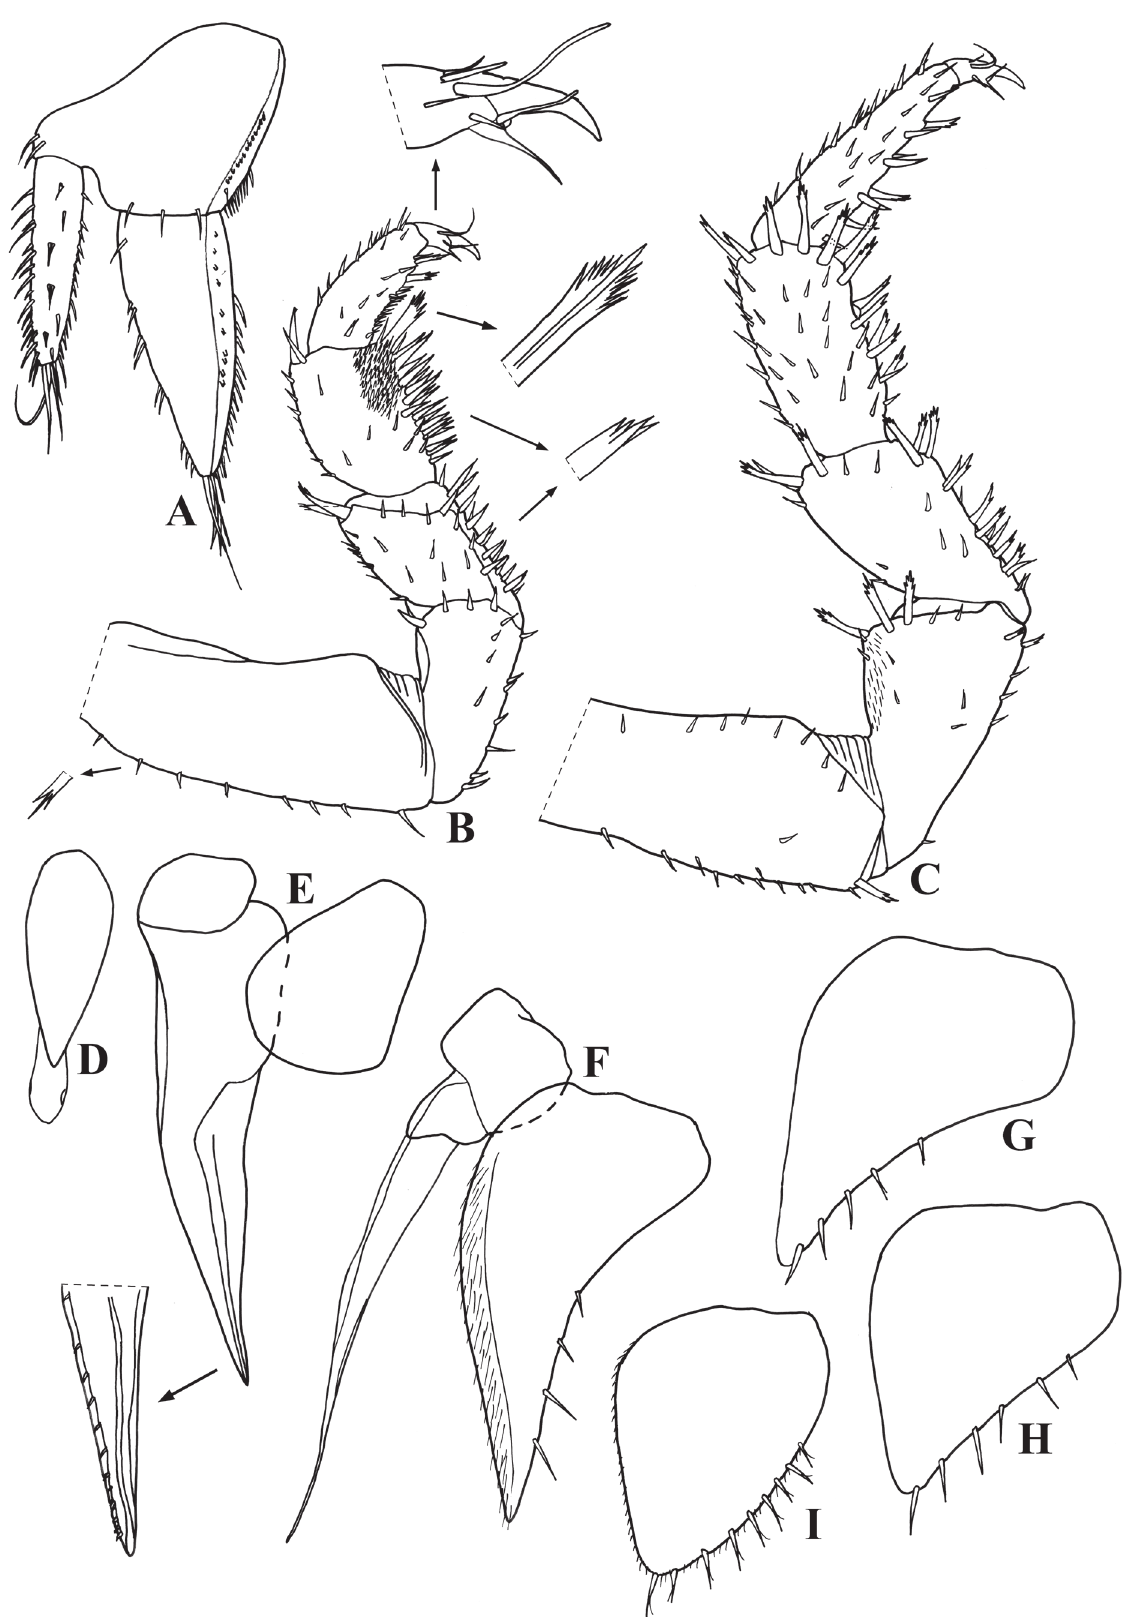
Figure 3 . Trichorhina kaingangi n. sp. (male paratype). A, uropod; B, pereopod; C, pereopod 7; D, genital papilla; E, pleopod 1; F, pleopod 1; G, pleopod 3 exopod; H, pleopod 4 exopod; I, pleopod 5